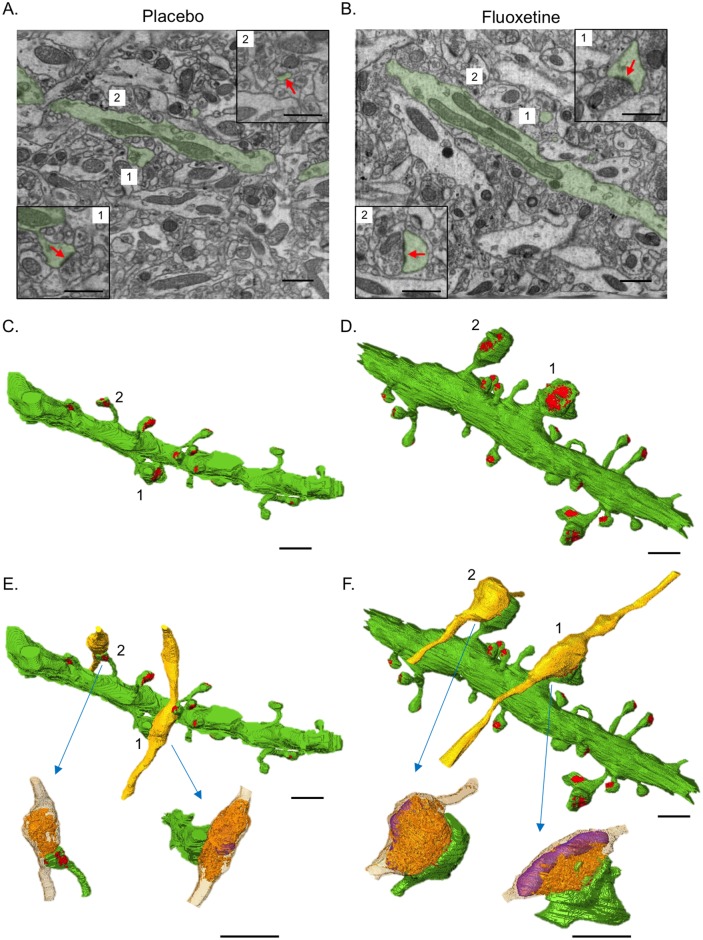
Three-dimensional reconstruction of perforant path-GC synapses in the dentate gyrus.(A, B) Full field SEM images obtained through FIB/SEM show the cross-sections of dendrites (green) in the placebo- (A) and fluoxetine (B)-treated mice. Insets show images of dendritic spines (green) and connecting boutons obtained in other sections. The arrows (red) indicate PSD. (C, D) 3D-reconstructed dendritic segments in the middle molecular layer of the DG in the placebo- (C) and fluoxetine (D)-treated mice. Note the appearance of the large-sized spines and PSDs (red) in the fluoxetine-treated mice. The dendritic spines, which are shown in the insets of Fig 1A and 1B, are indicated with numbers. (E, F) Three-dimensional reconstructed presynaptic boutons are visualized at two synapses in the placebo- (E) and fluoxetine (F)-treated mice. The synaptic vesicles (orange) and mitochondria (purple) are shown inside the presynaptic boutons. Note that the large-sized spines are in contact with large-sized presynaptic boutons. Scale bars: 1 μm.